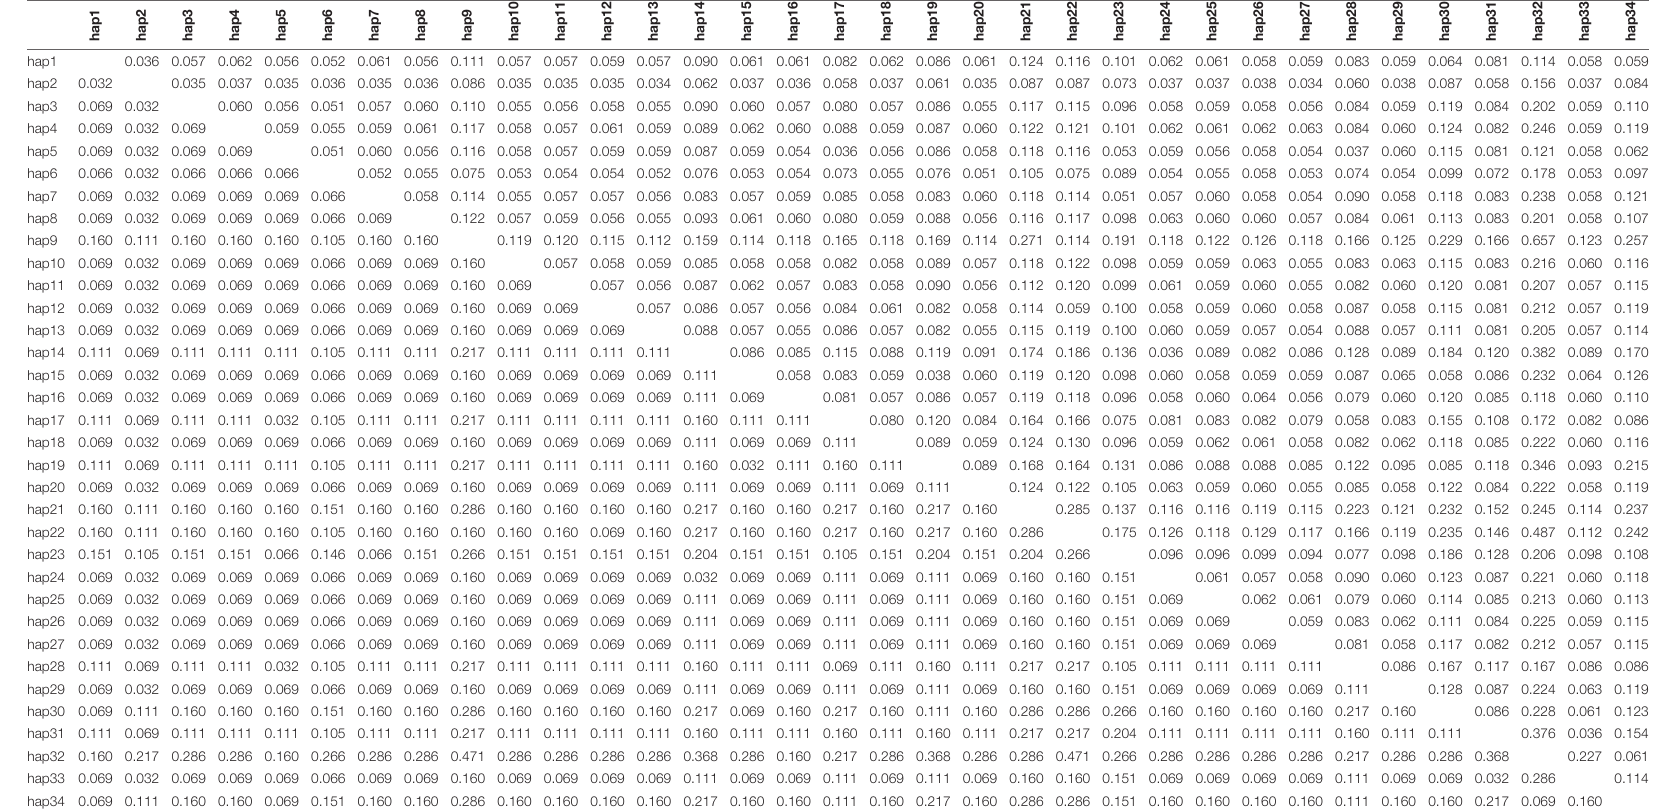
TABLE 4 | Pairwise genetic distance among 34 mitochondrial cox1